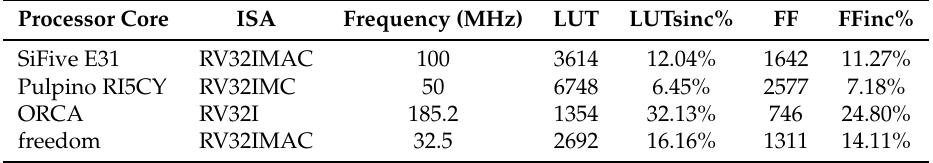
Table 6. Resources used on the synthesis of different CPUs implementing multiple ISA’s